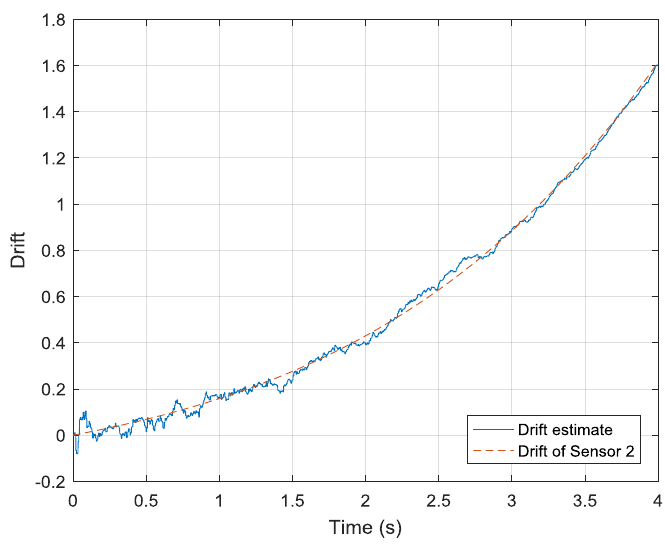
Figure 6. Drift-state estimation process.